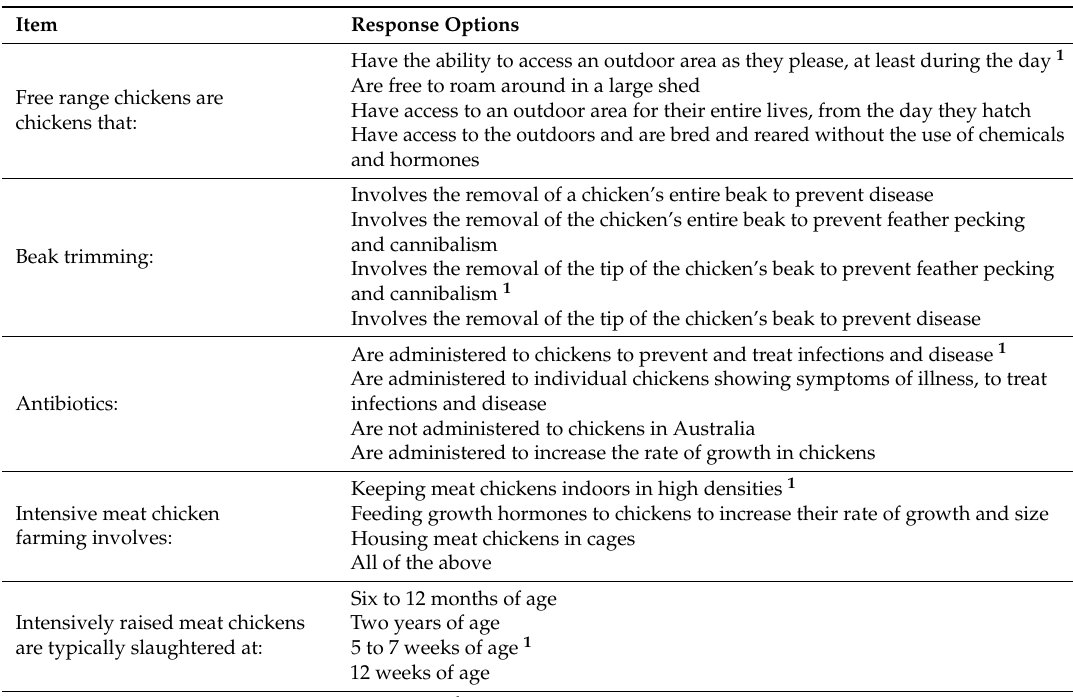
Table 1. Items measuring objective knowledge of chicken management